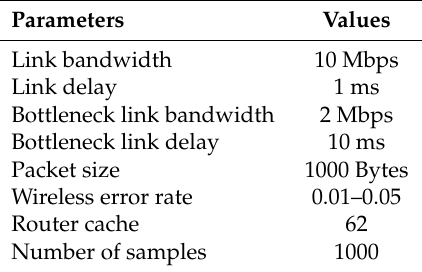
Table 1. Simulation